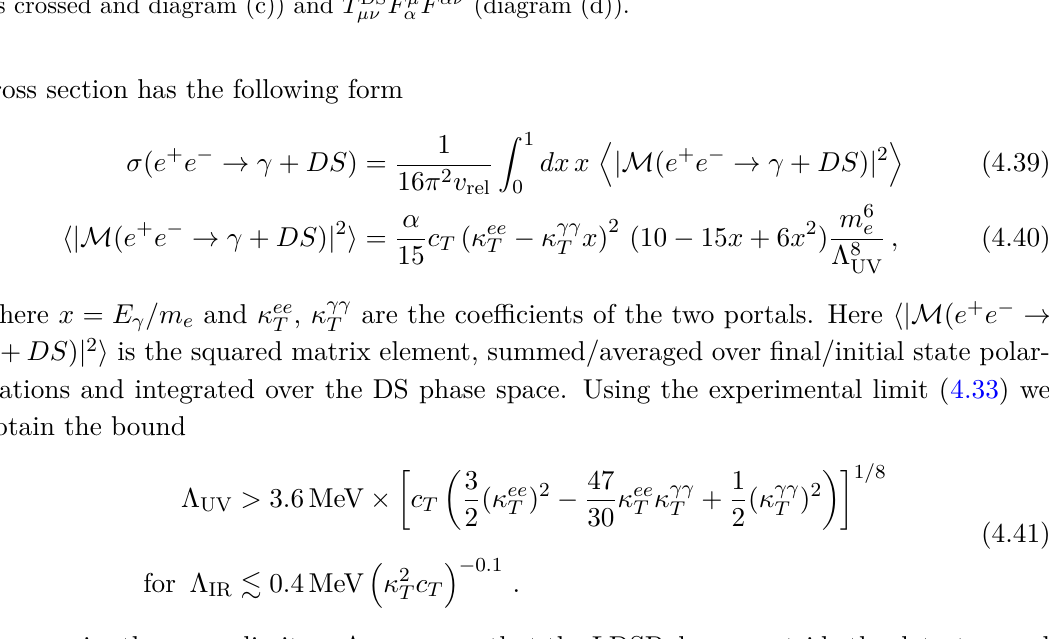
(¯ eγ µ D ν e ) (diagram (b) plus µν